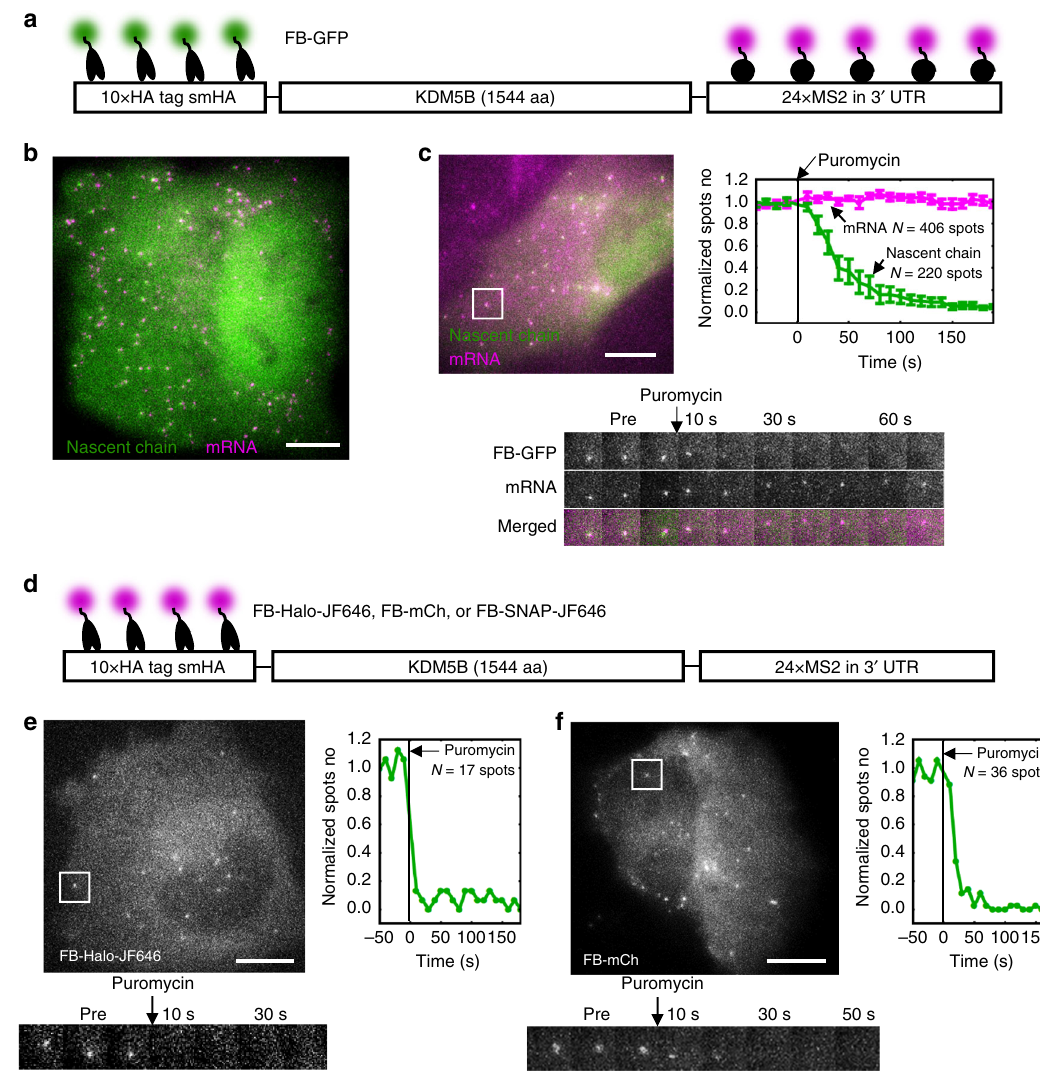
Fig. 6 Tracking single mRNA translation in living U2OS cells. a A diagram depicting frankenbody (FB-GFP; green) and MCP-HaloTag-JF646 (magenta) labeling HA epitopes and mRNA stem loops, respectively, in a KDM5B translation reporter. b A representative cell (10 cells in three independent experiments) showing colocalization of FB-GFP (green) with KDM5B mRNA (magenta). See also Supplementary Movie 3. c A representative cell (upper- left, 9 cells in three independent experiments) showing the disappearance of nascent chain spots labeled by FB-GFP within seconds of adding the translational inhibitor puromycin. See also Supplementary Movie 4. Upper-right: The mean number of nascent chain spots normalized to pre-puromycin levels decreases while mRNA levels remain constant (9 cells from three independent experiments). Error bars, cell-to-cell SEM. Lower: a sample single mRNA montage. d A diagram depicting FB-Halo-JF646, FB-mCh, or FB-SNAP-JF646 labeling HA epitopes in a KDM5B translation reporter. e , f Representative cells (three cells in two independent experiments for both FB-Halo and FB-mCh), single mRNA montages, and quanti fi cation, as in c , showing the loss of nascent chain spots labeled by e FB-Halo-JF646 or f FB-mCh upon puromycin treatment. See also Supplementary Movies 5 and 6. Scale bars, 10 µ m. Source data are provided as a Source Data fi